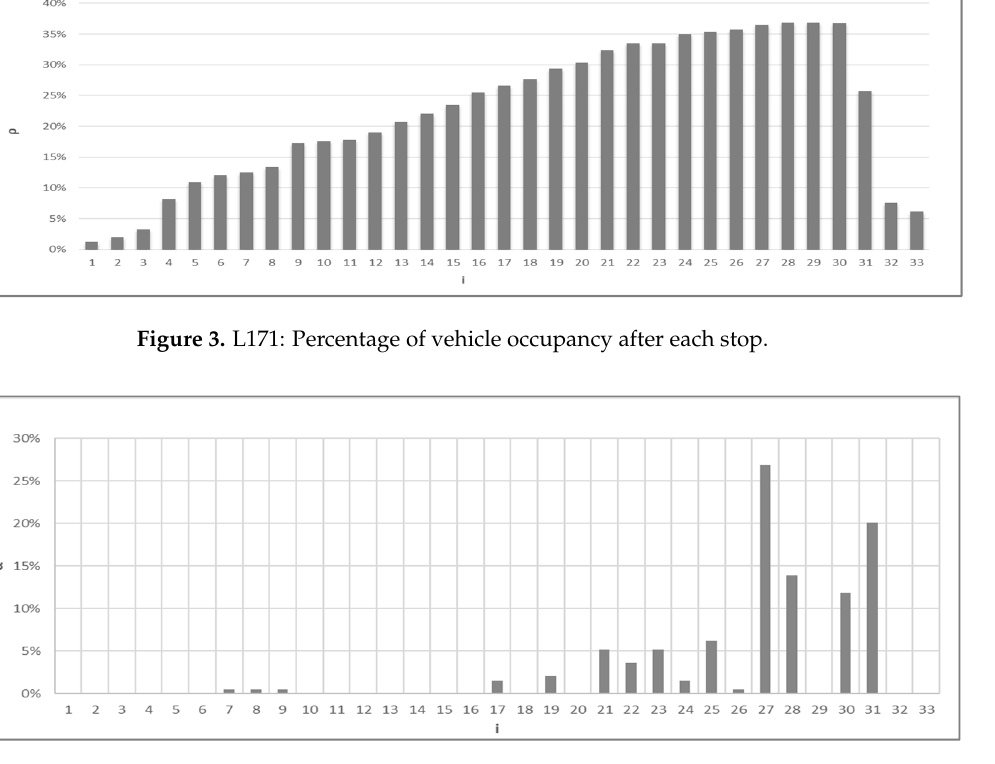
Figure 5. L171: Occupancy percentage in the vehicle at the stops where Maximum Occupancy was observed. Stops That Were Not a Point of Maximum Occupancy on Any of the Examined Routes Have Been Omitted The statistical analysis per day focuses on the average travel distance covered by pas- sengers per day of the week. In Table 3, the passenger travel distance (km) per bus line and time period is presented. By examining the average value and standard deviation of the distance travelled, we notice that the distances are longer and with higher uncertainty in the time periods which are associated with trips from/to the work and school. This shows a fall in the Quality of Service during these time periods. This is not unexpected, as the traffic is heavier in these hours, with more vehicles circulating. In Table 4, we extend this analysis by presenting the average travel distance per passenger per day for all of the bus lines. The comparative table of travel distance per day shows that the passengers travel the longest on Mondays, while the rest of the days follow with small differences.